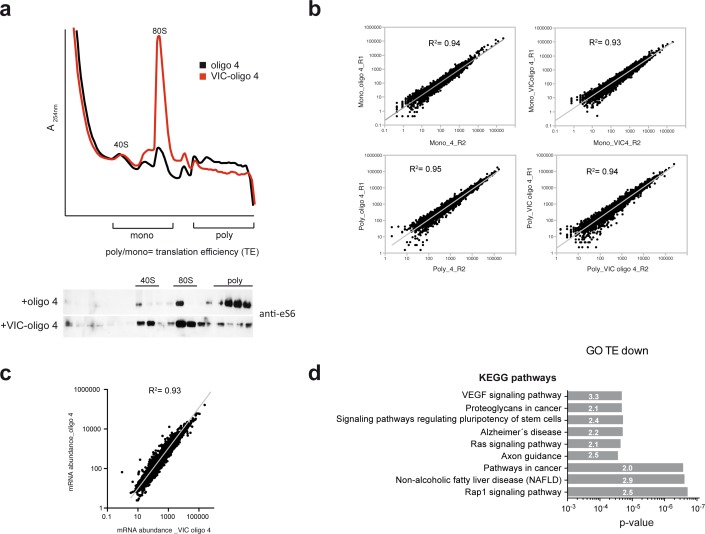
Quality and reproducibility of the experiment shown in Figure 5.(a) Polysome profile of HEK293T cells transfected with the indicated oligonucleotides. This experiment corresponds to the replica_1 used for RNA-seq, indicating fractions pooled as monosomes or polysomes. The bottom panel shows a western blot analysis of the resulting fractions probed with anti-eS6 antibody. (b) Analysis of correlation between replicas using a normalized number of reads for every mRNA in the monosomal and polysomal samples. (c) Changes in mRNA abundance between oligo 4 and VIC–oligo-4-transfected cells. Data are the average from two replicates. (d) Enrichment in KEGG pathways detected in the ‘TE down’ group of mRNAs. The p-value and enrichment factor for each term are indicated.